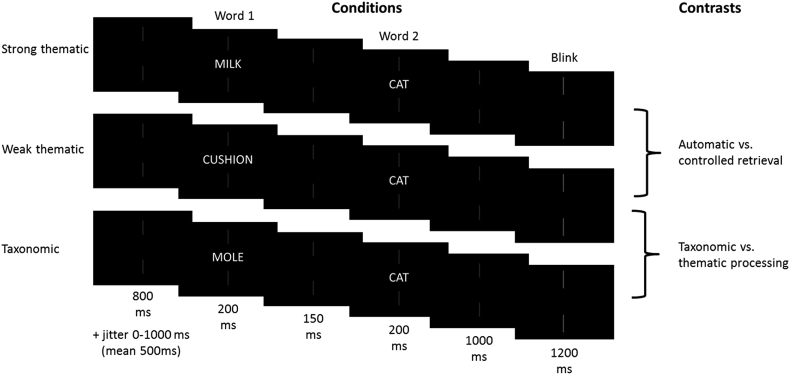
Illustration of strong thematic, weak thematic and taxonomic trials. The words are not to scale; for visibility they have been made larger and brighter.